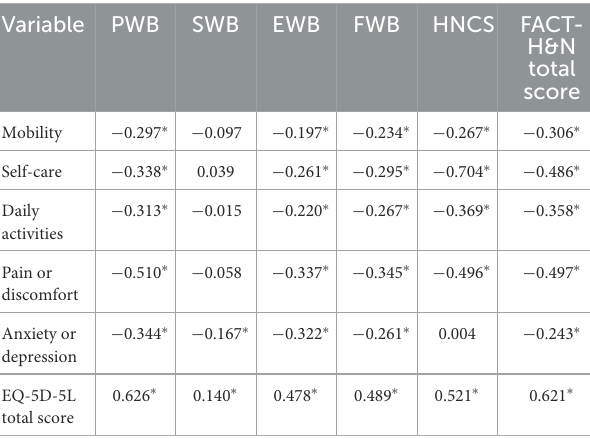
health utility score when not perfectly healthy and then combines the two models to obtain the final health utility value.